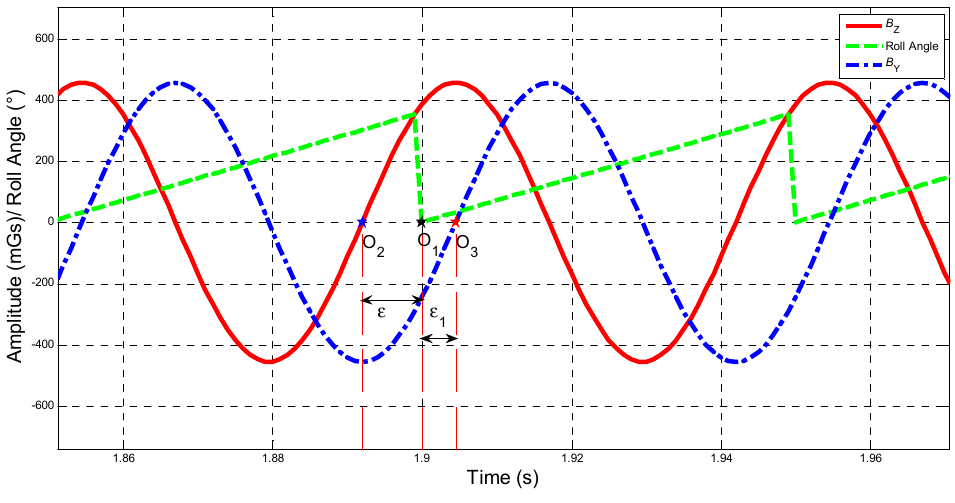
Figure 3. Description of compensation angle.